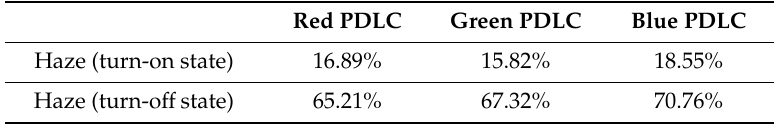
Table 2. Measured hazes of the color PDLC devices.